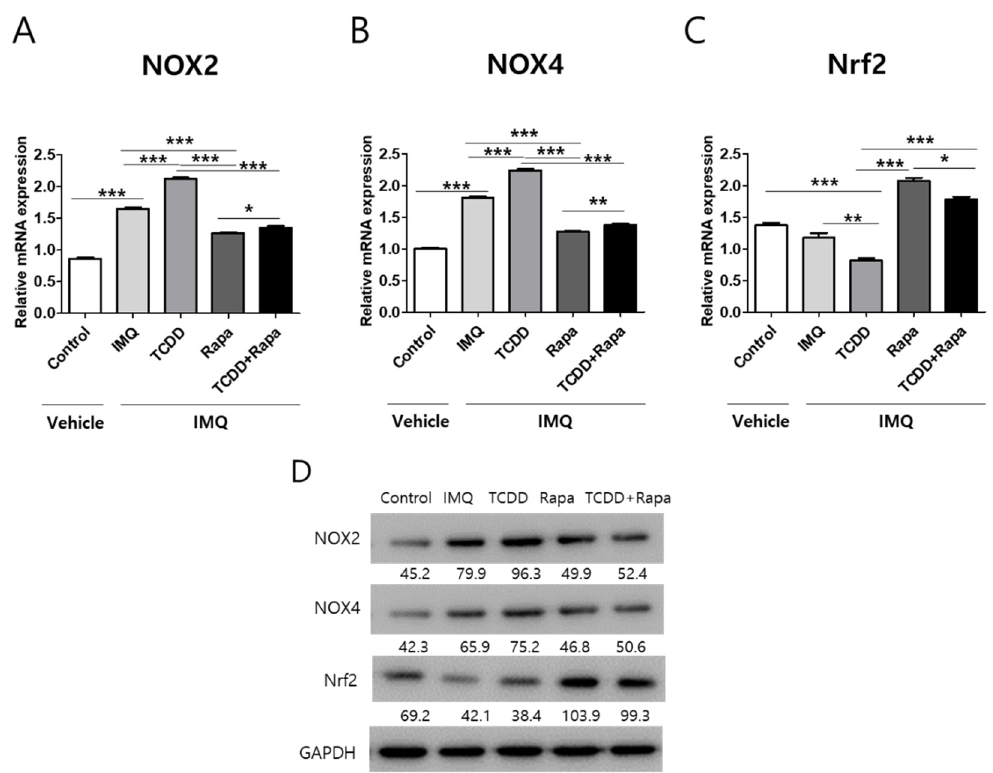
Figure 8. The effects of TCDD and rapamycin on the expression of oxidative stress-related factors. mRNA and protein expressions change in mouse skin tissue after treatment with vehicle control, IMQ, IMQ + TCDD, and IMQ + Rapa, or IMQ + TCDD + Rapa. ( A – C ) qPCR and ( D ) Western blot analyses of NOX2, NOX4, and Nrf2 expressions in mice treated with 5 different regimens ( n = 5 per group). qPCR data represent the mean ± SD of three independent experiments (each performed in duplicate). Statistical differences were determined by one-way analysis of variance (ANOVA) with Dunnett’s post hoc test. * p < 0.05; ** p < 0.01; *** p < 0.001. Western blot normalization was based on GAPDH. Western blot data are representative of three independent experiments. Rapa: rapamycin; IMQ: imiquimod.